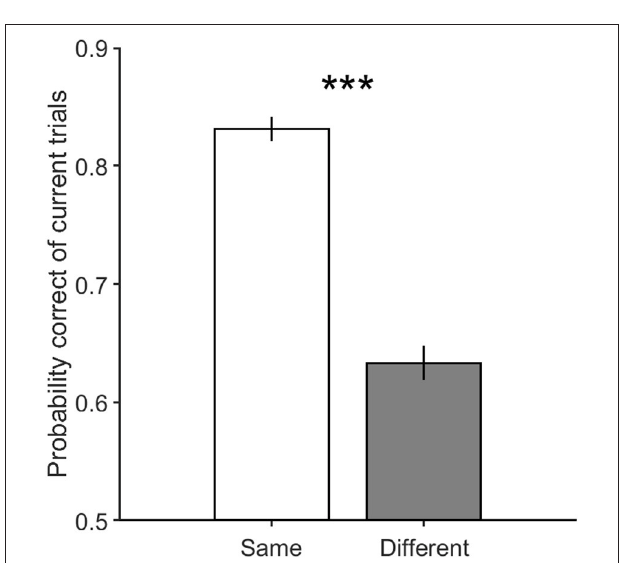
FIGURE 6 | The performance of the current trials which includes motion strengths of 3.2, 6.4, and 12.8% when their previous trials are 0%. Error bars indicate SE (Standard Error). Wilcoxon rank-sum test is used to test the significance of the difference, *** p < 1E −